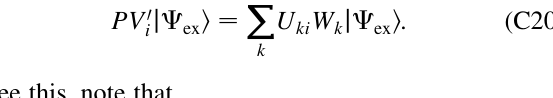
P U W PV 0 ki k and k i .